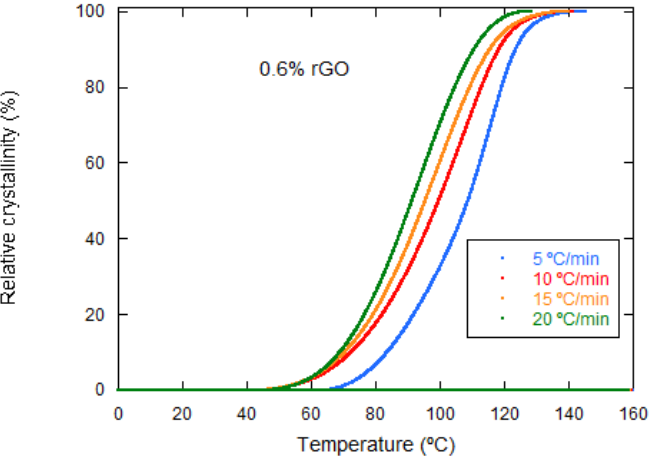
Figure 6. Relative crystallinity versus temperature of PLCL/rGO 0.6 wt% at different cooling rates.